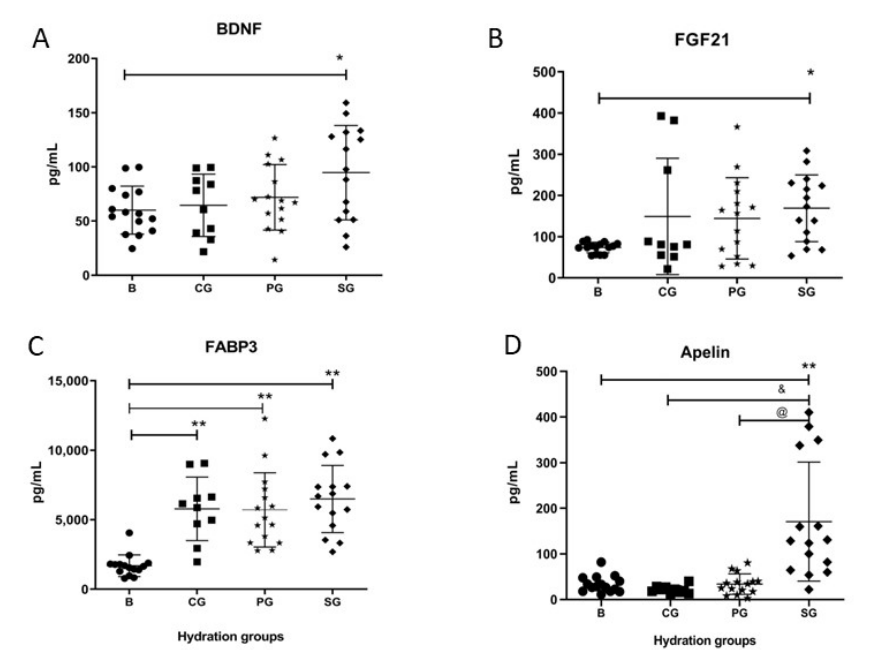
Figure 1. Expression of myokine proteins related to glucose metabolism and synaptic function. ( A ) The BDNF increased at increased post-exercise in experimental group (SG). ( B ) FGF 21 expression values showed a significant increase post-exercise only in the SG. ( C ) FABP3 expression values change in each groups post-exercise. ( D ) The apelin increased at increased post-exercise in SG. CG, Control Group; BG, Basal; PG, Placebo group. Each participant is represented with a symbol. Data are shown as means ± SD. * p < 0.05 basal vs. post-exercise of each group. ** p < 0.001 basal vs. post-exercise of each group. @ p < 0.05 SG vs. PG. & p < 0.05 SG vs. CG.